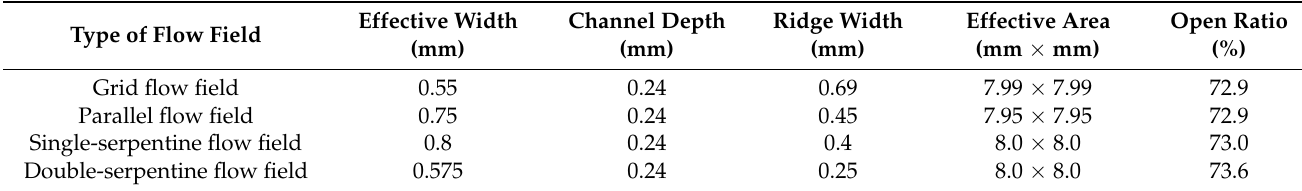
Table 1. Geometric parameters of four types of flow